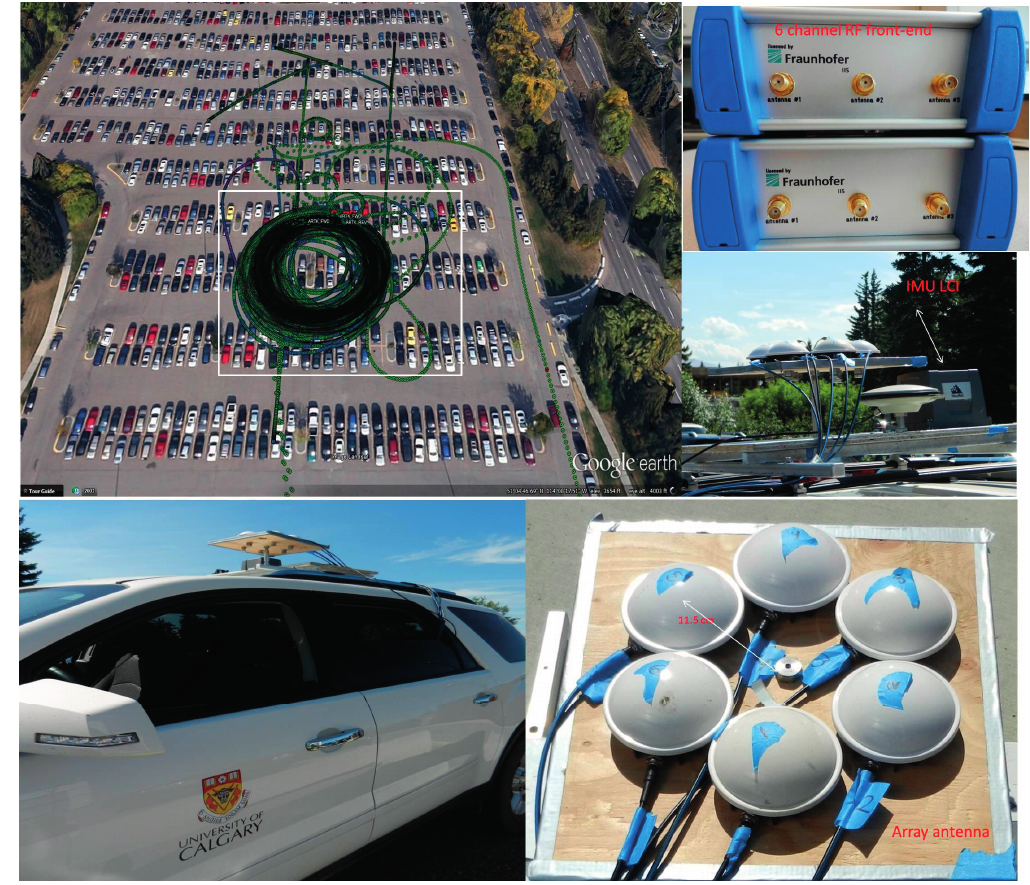
Figure 3. Data collection scenario and setup.